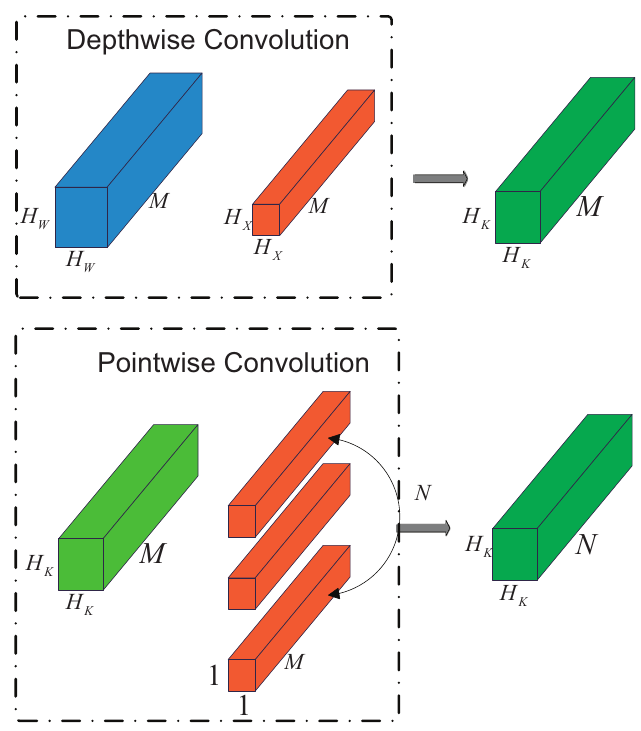
Figure 4. Depth separable convolution calculation process. SMYOLO’s depth separable convolution requires the amount of calculation to com- plete this process is shown in Equation (2).